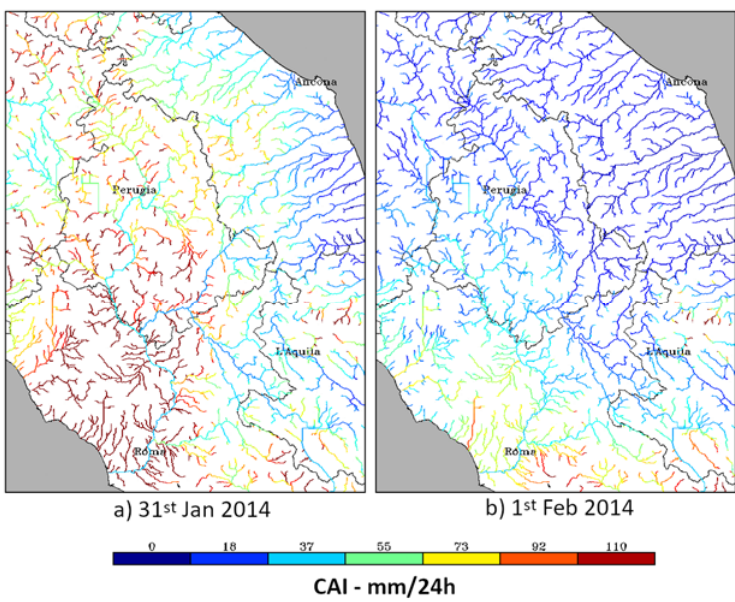
Figure 8. CAI index daily maps for relevant days of the weather event.